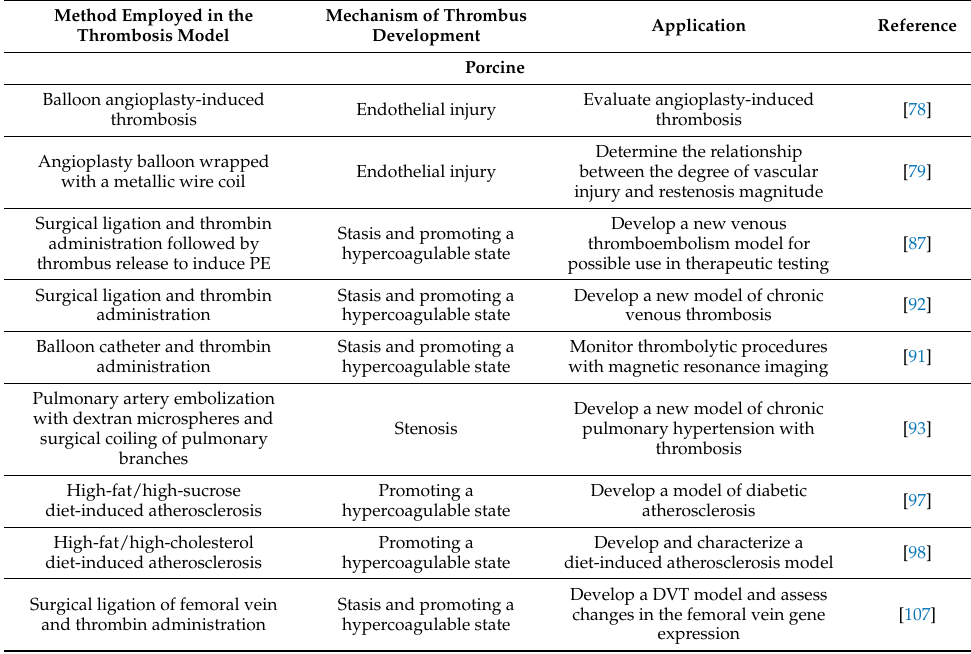
Table 2. A list of some common animal thrombosis